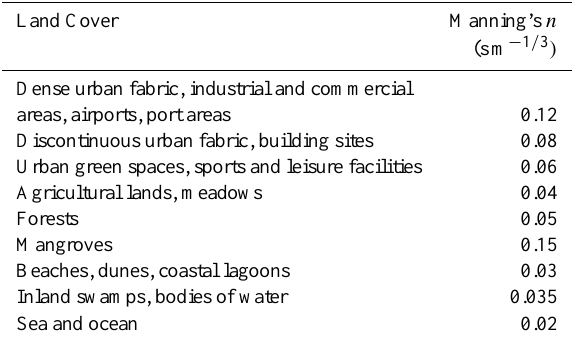
Figure 6. Mesh resolution (in metres) in the Guadeloupe area. Table 1. Manning coefficients for various categories of land